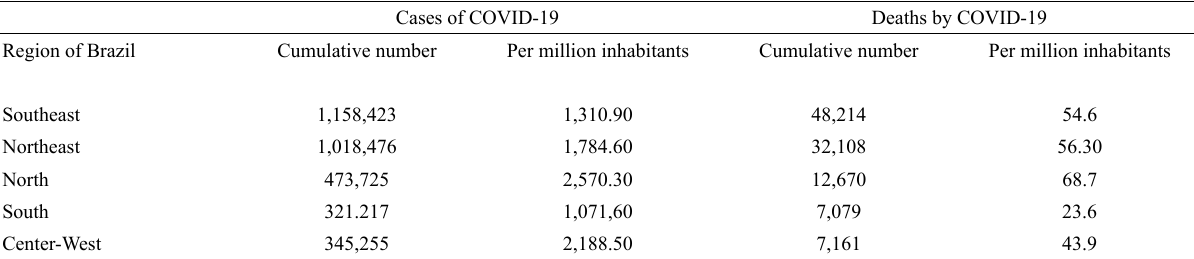
Table 1 – Number of cases and deaths by COVID-19 in different regions of